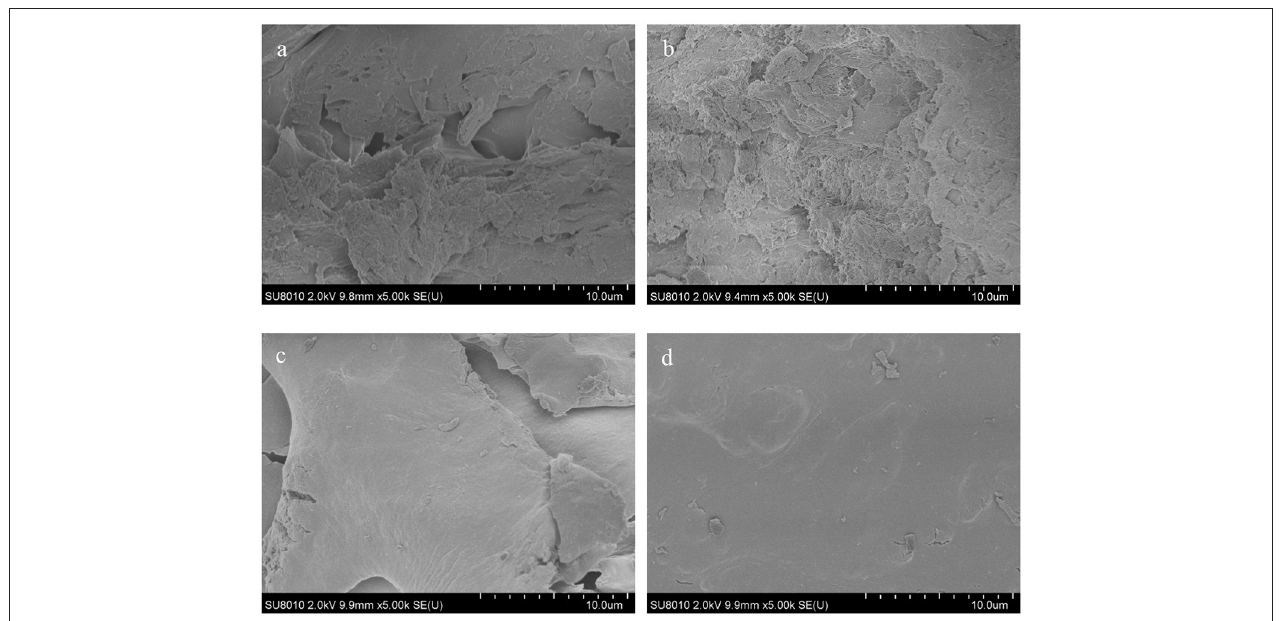
FIGURE 4 | Scanning electron micrographs of RS with or without LSOPC, RS (A) , RS + 3% LSOPC (B) , RS + 6% LSOPC (C) , and RS + 9% LSOPC (D) .